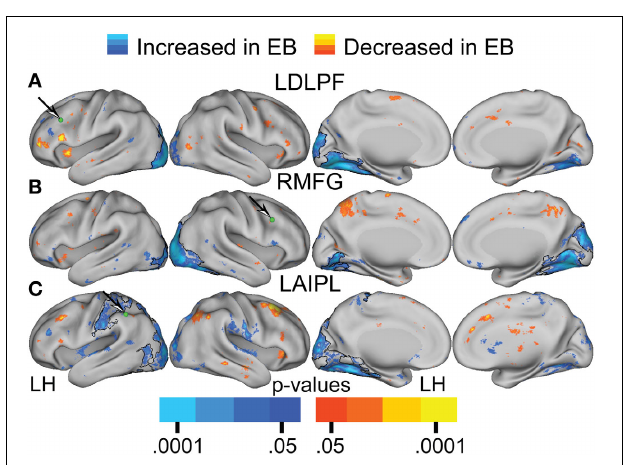
FIGURE 7 | Contrast of NS compared to EB functional connectivity based on two-tailed t- test for selected seed regions (A–C) identified in Table 2. See text for Figure 5